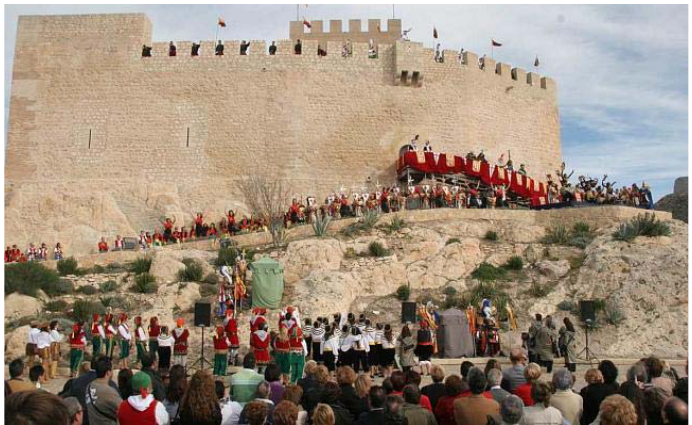
Image provided by Fiestas de Moros y Cristianos [29]. Figure 4. The “Basque Christians” advance, seeking “reconquest”. Town of Alcoy, Alicante province, 2006.